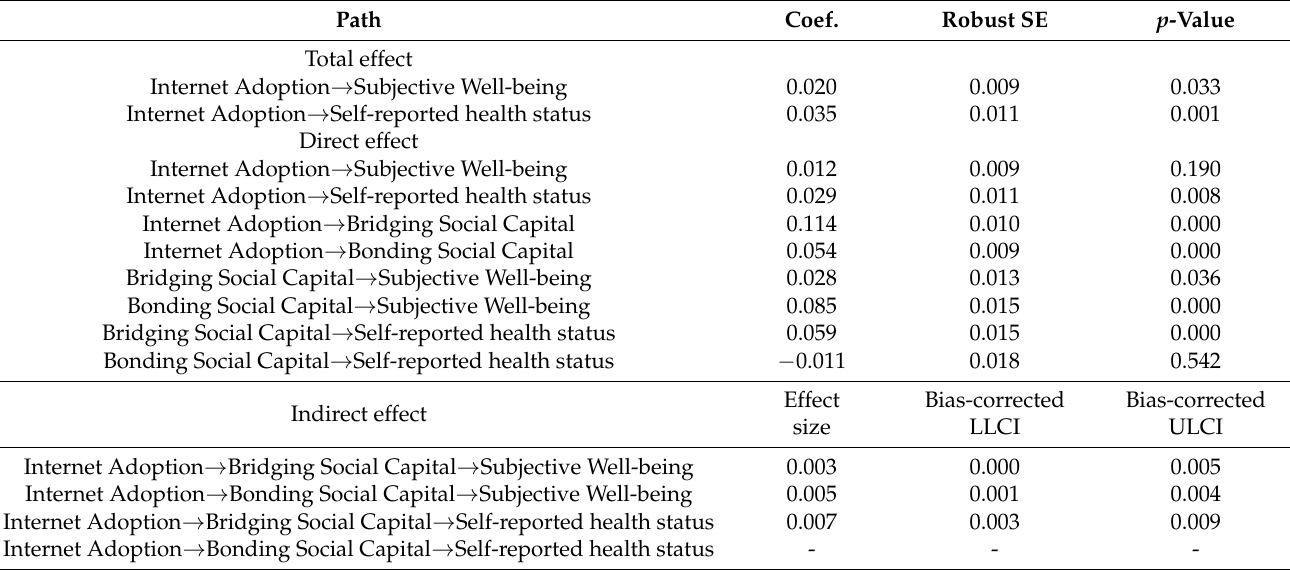
Table 4. Coefficients of structural equation